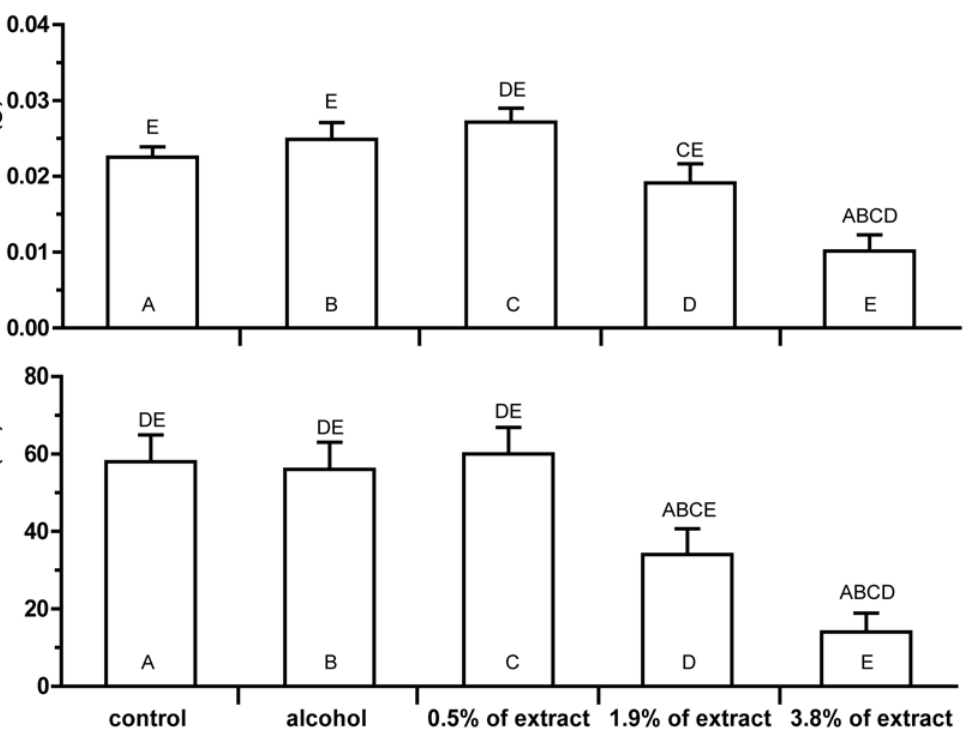
Fig 5. Effect of Betula pendula leaf surface ethanol extract on Lymantria dispar fitness. Weight (mean ± SE) (a) and survival rate (mean ± SE) (b) of Lymantria dispar larvae reared on artificial diet with different concentrations of leaf surface extract is presented. The data were pair-wise compared by post hoc Fisher LSD procedure. The letters above the bar mean the significant differences (at P < 0.05) to be compared with the bars abbreviated by the same letters within bar.